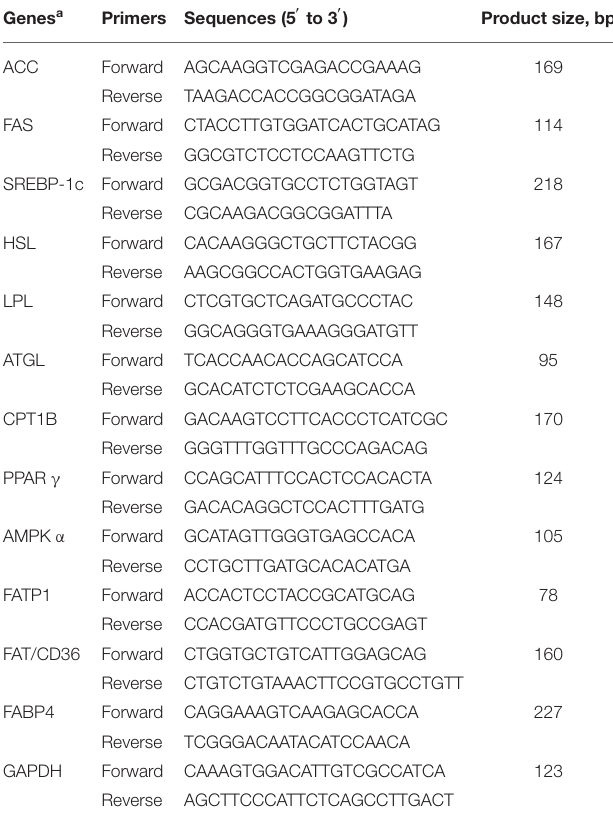
TABLE 3 | Growth performance of growing and growing–finishing pigs fed the diets with various levels of